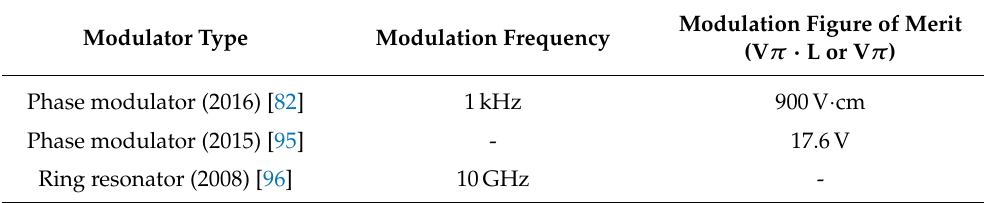
Table 5. The characteristic comparison of fabricated EO-polymer modulators based on SiN